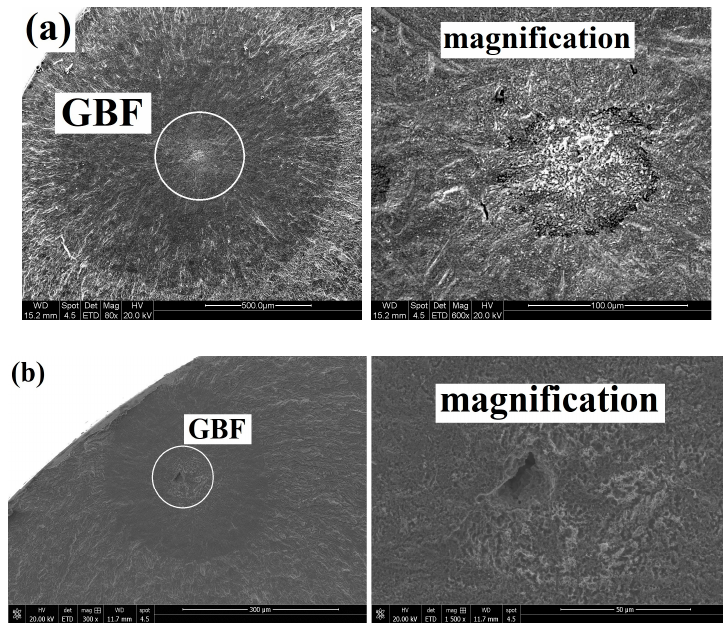
Figure 4. The GBF (Granular Bright Facet) region. ( a ) the GBF region, ( b ) the GBF region.